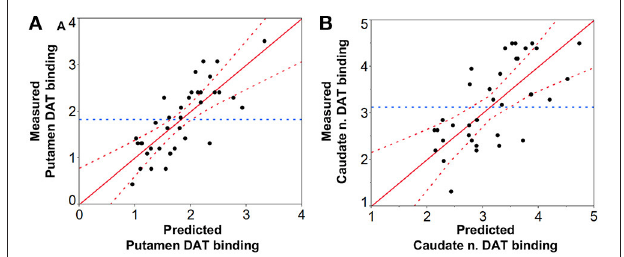
FIGURE 6 | Prediction analysis of DAT binding values of the (A) putamen and (B) caudate nucleus based on NM-MRI findings. Prediction of DAT binding values was significant for both the putamen ( p < 0.0001, R 2 = 0.61, RMSE = 0.48, PRESS = 9.33) with SN volume being the best predictor ( p < 0.0001) ( CNR SN leverage: p = 0.22, and CNR LC leverage: p = 0.29), and the caudate nucleus ( p < 0.0001, R 2 = 0.50, RMSE = 0.73, PRESS = 21.53) again with SN volume as the best predictor ( p < 0.01) ( CNR SN leverage: p = 0.11, and CNR LC leverage p = 0.32). RMSE = Root mean square error; PRESS = Predicted residual error sum of